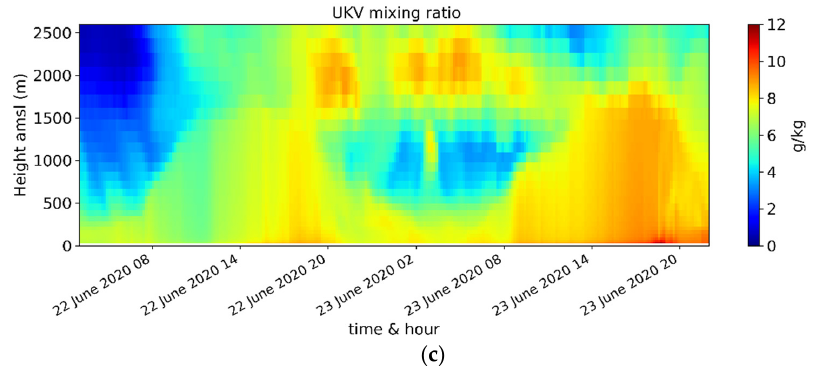
Figure 18. ( a ) range corrected backscatter, ( b ) BB-DIAL mixing ratio, ( c ) UKV mixing ratio.